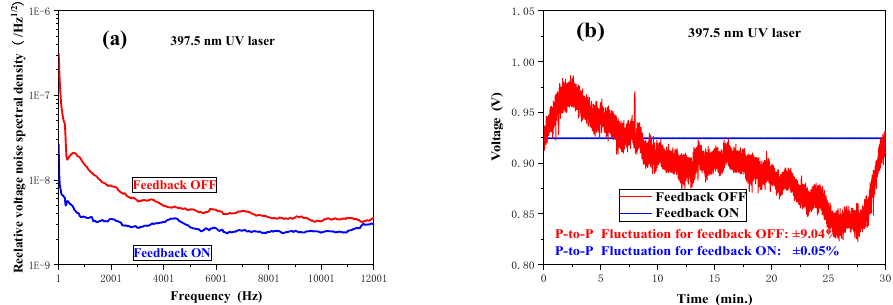
Figure 3. Comparison of laser intensity noise of 397.5-nm UV laser beam for feedback system on and off. ( a ) The effective feedback bandwidth is ~11.5 kHz. ( b ) In time domain, typical peak-to-peak fluctuation of 397.5-nm UV laser intensity is improved from ± 9.04% to ± 0.05%. The stability has been improved by a factor of ~180.